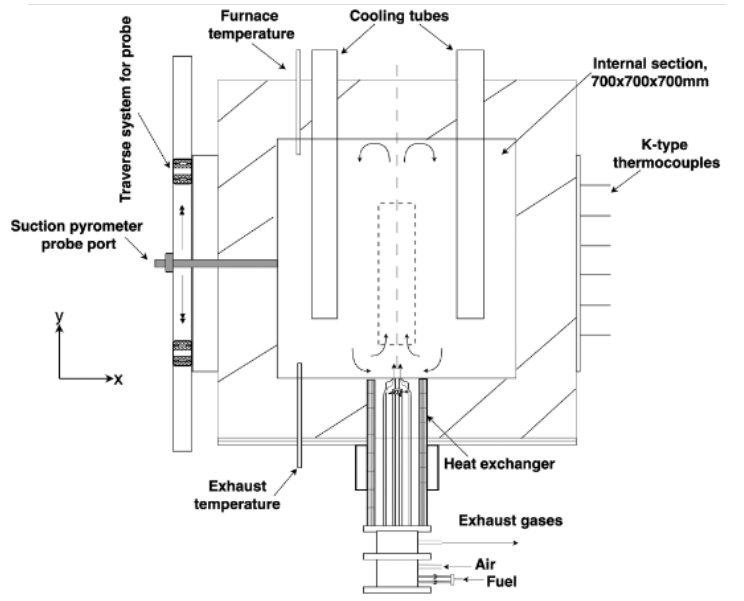
Figure 1. Vertical cross-section of the ULB semi-industrial furnace. The dashed lines represent a projection of the quartz window on the vertical cross-section